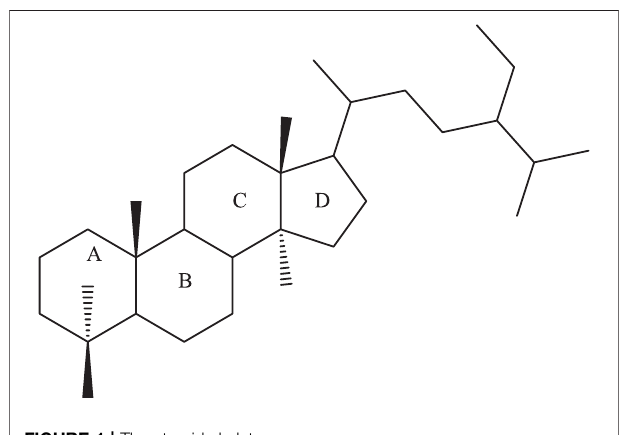
FIGURE 1 | The steroid